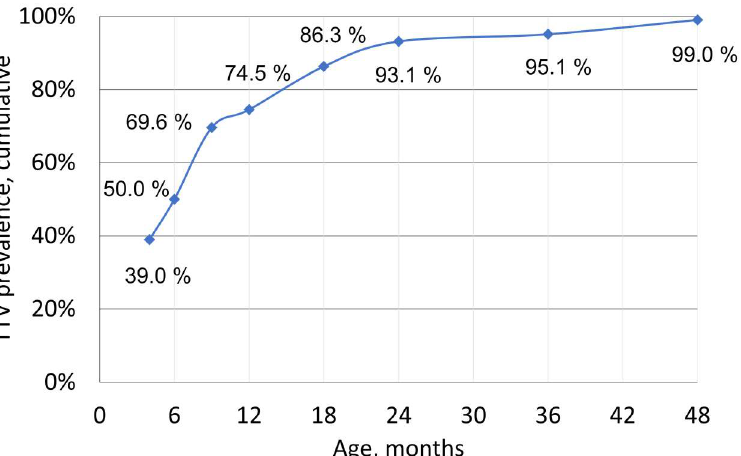
Figure 1. Cumulative TTV DNA prevalence in children. The time points (4, 6, 9, 12, 18, 24, 36, and 48 months of age) depict the percentages of children with TTV DNA in one or more samples prior to that age. The first time point was set at <4 months instead of <3 months as there were too few samples from infants <3 mo of age. At the <4-month time point, samples from 77 children were available, of which 30/77 (39%) were TTV-DNA-positive. At the <6-month time point, samples from 98 children were available and 49/98 (50%) of the children had become TTV-DNA-positive. For the other time points, the curve depicts the cumulative TTV prevalence of the entire cohort comprising 102 children.